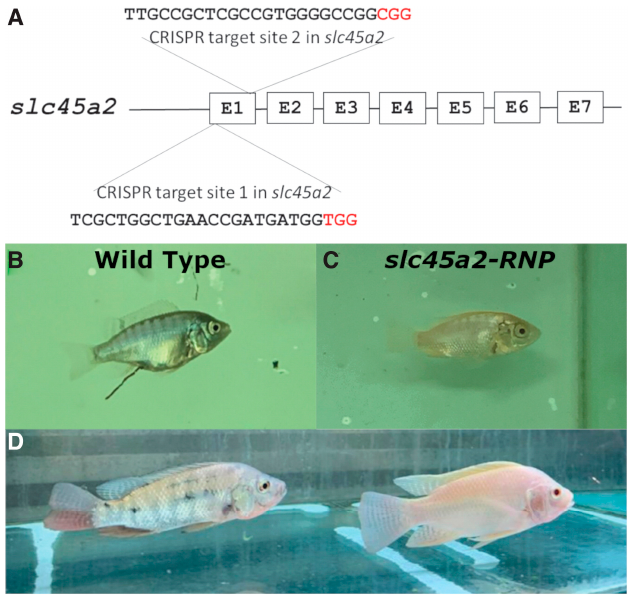
Figure 10. Different phenotypes between wild adult and slc45a2 mutant adult Nile tilapia Figure 10 shows the phenotypic analysis of tilapias after microinjected at the single-cell stage with RNPs. ( A ) shows Nile tilapia zygotes were containing slc45a2 - exon1 -specific gRNAs 2 and 3. ( B ) shows the embryo with a normal gray-black pattern and dark eyes at 1-month post fertilization. ( C ) shows slc45a2 -RNPs-injected mutant fish with 97–99% loss of melanin in the skin and no melanin in the eye. ( D ) shows post sexual maturation, F0 mutant displaying a complete loss of melanin [102].